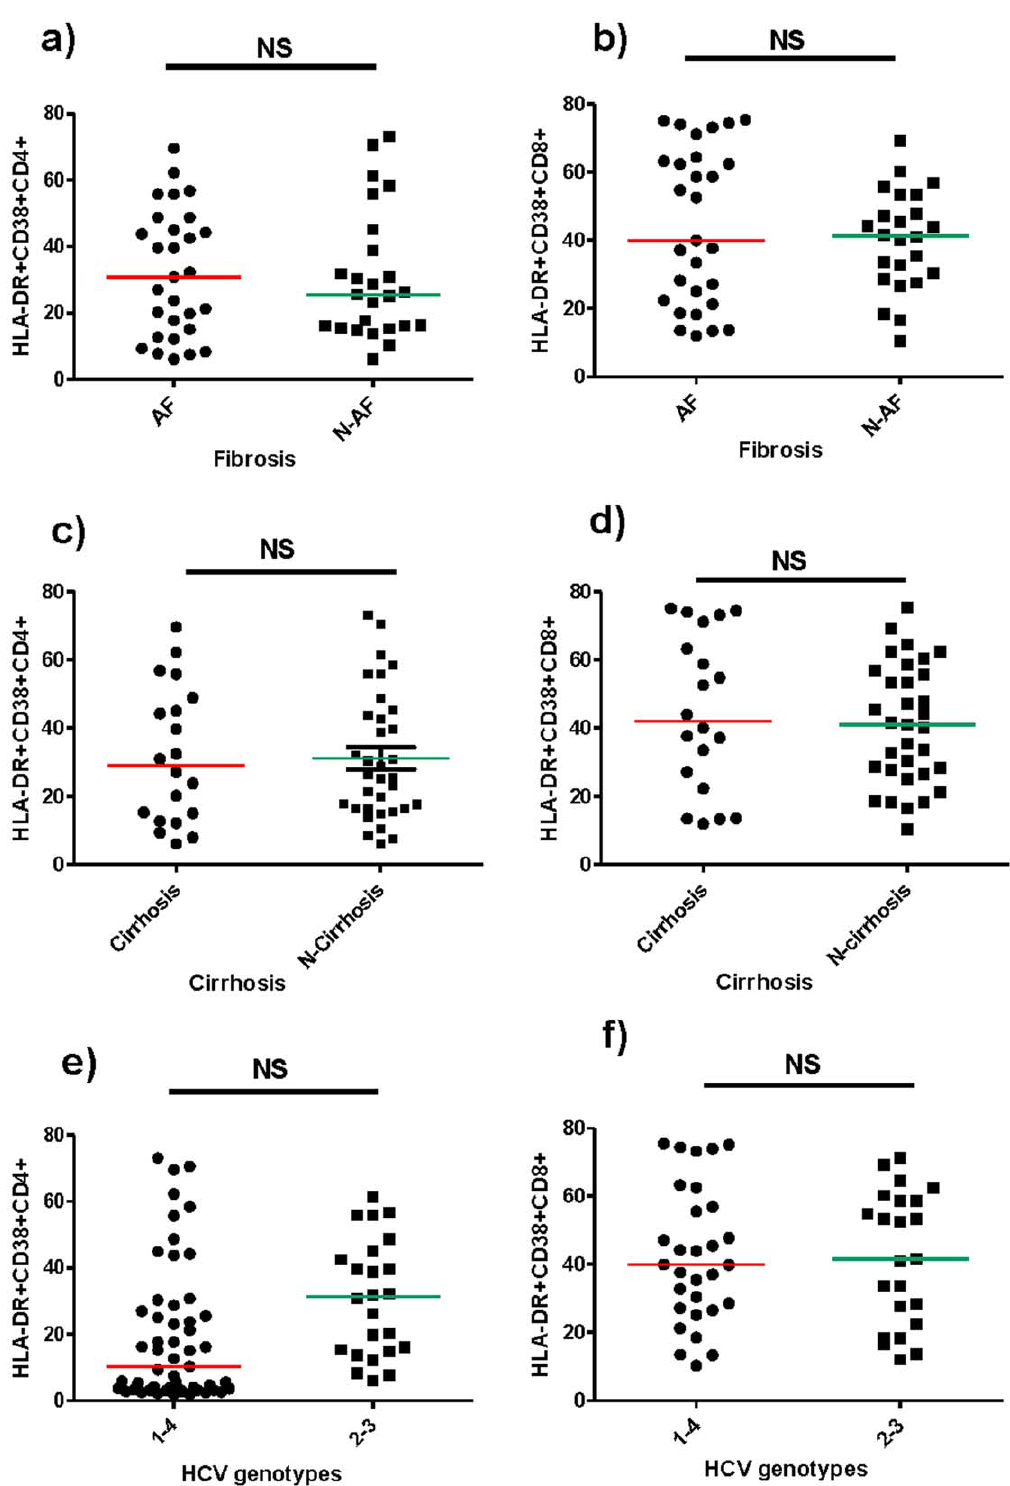
Figure 2. Activated HLA-DR + CD4 + and CD8 + T-cells according to liver fibrosis, cirrhosis and HCV genotypes. a ) -b ) Activated HLA- DR + CD4 + and CD8 + T-cells were compared between patients with advanced fibrosis (AF) and non advanced fibrosis (N-AF). c ) -d ) Activated HLA- DR + CD4 + and CD8 + T-cells were compared between patients with cirrhosis and absence of cirrhosis (N-Cirrhosis). e ) -f ) Activated HLA-DR + CD4 + and CD8 + T-cells were compared between patients with HCV genotypes 1–4 and genotypes 2–3. Each point represents the value from one subject’s plasma. Activated HLA-DR + CD4 + and CD8 + T-cells % values are presented. AF=advanced fibrosis – N-AF=non advanced fibrosis. p-values were assessed by Mann Whitney U test. p . 0.05 was considered non significant (NS).